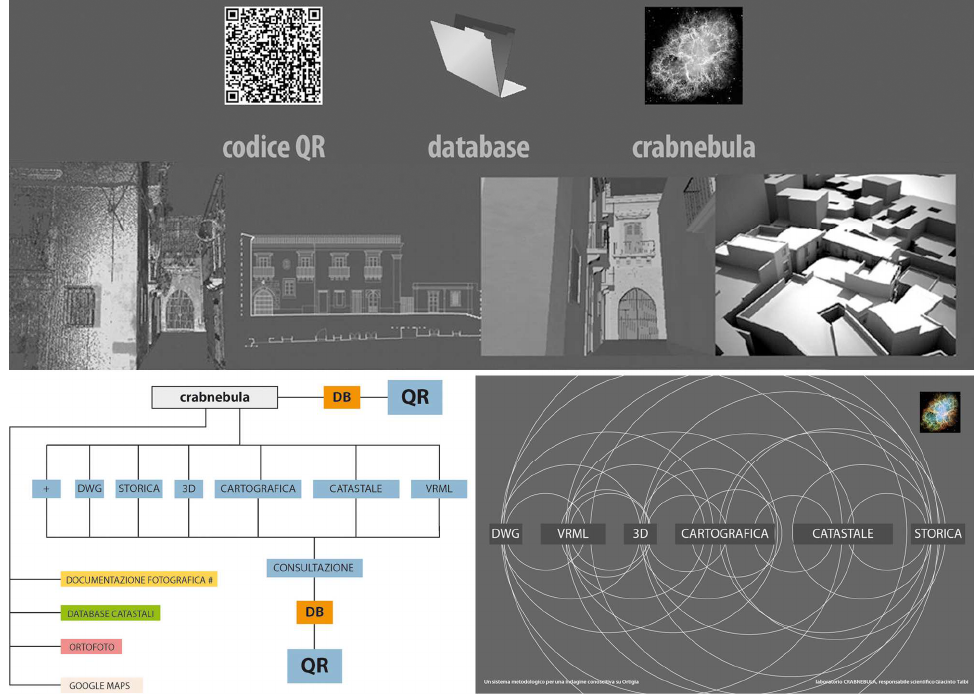
Figure 4. The process of knowledge based on exploring, analyzing, knowing, sharing and